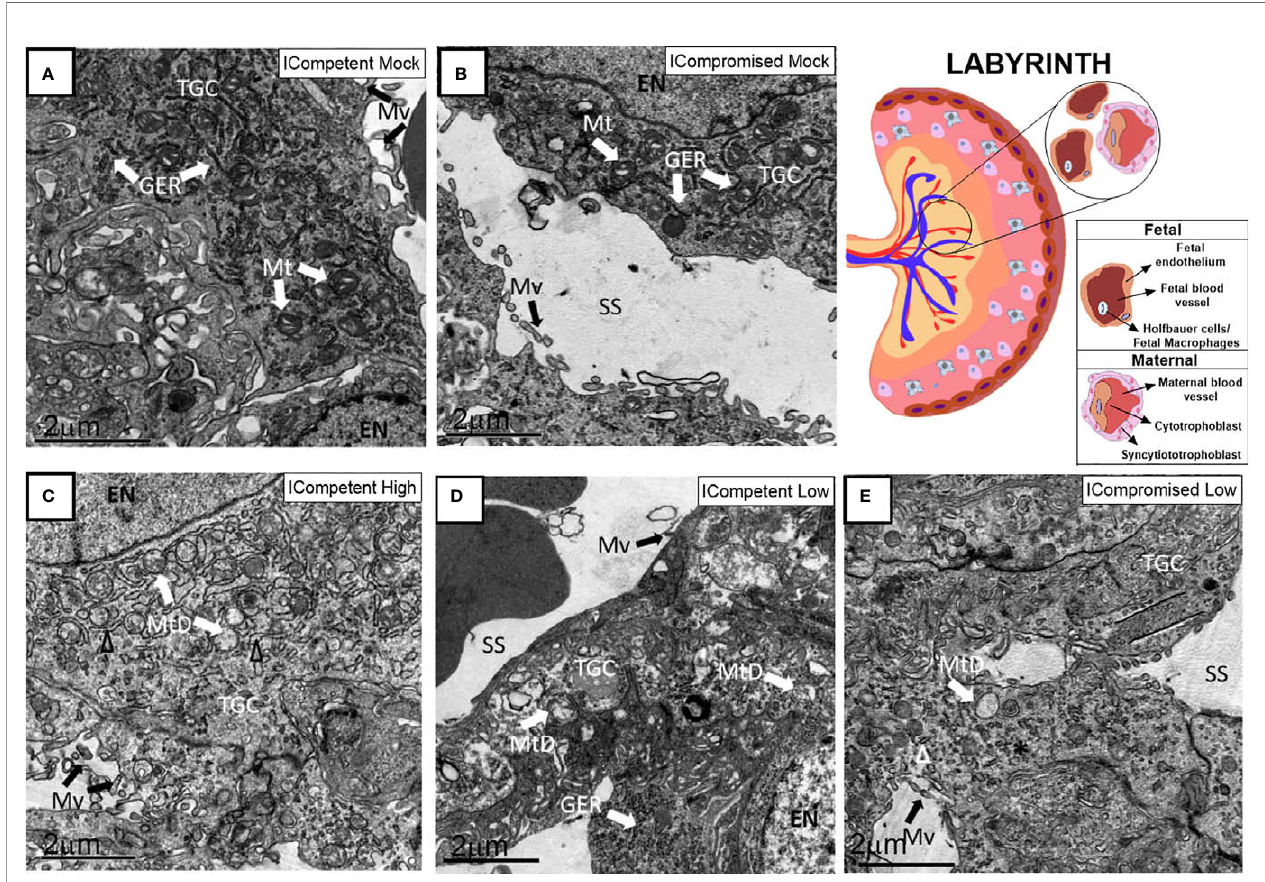
FIGURE 6 | Associated ultrastructural changes in the placental Lz after ZIKV infection. Transmission electron photomicrographs of ICompetent mock (A) , ICompromised mock (B) , ICompetent high (C) , ICompetent low (D) and ICompromised low (E) groups (n=5/group). We observed dilatation in the ER cisterns of ICompetent high placentas. Additionally, there was a reduction in the microvilli in both the ICompetent high and ICompetent low placentas. In the ICompromised low group, we found fragmented ER and microvillus reduction. All infected groups showed degenerate mitochondria. GER = granular endoplasmic reticulum; D = dilated granular endoplasmic reticulum; * = fragmented granular endoplasmic reticulum; Mt, mitochondria; MtD, degenerate mitochondria; Mv, microvilli; EN, euchromatic nuclei; SS, sinusoidal space; TGC, trophoblastic giant cell. Scale bar = 2